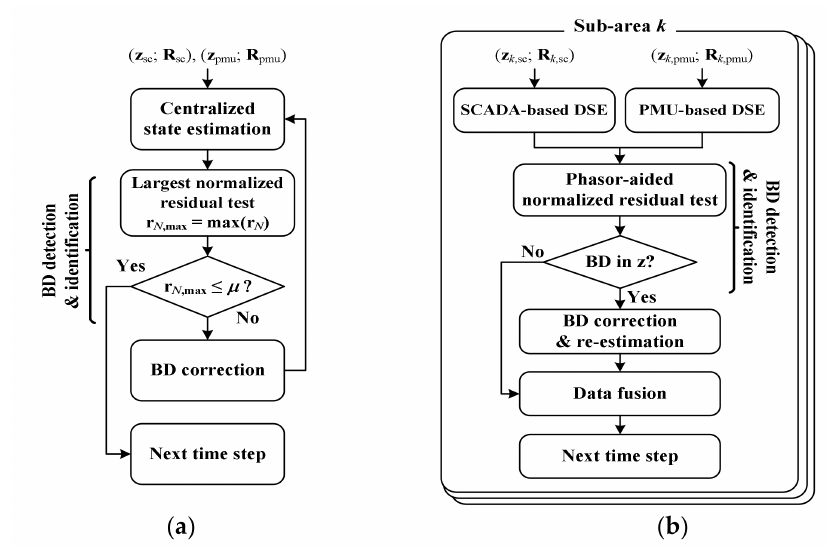
Figure 16. Flowcharts of ( a ) a conventional, centralized hybrid SE strategy and ( b ) a proposed, de- centralized PHASE strategy, both of which include BD detection, identification, and correction steps.